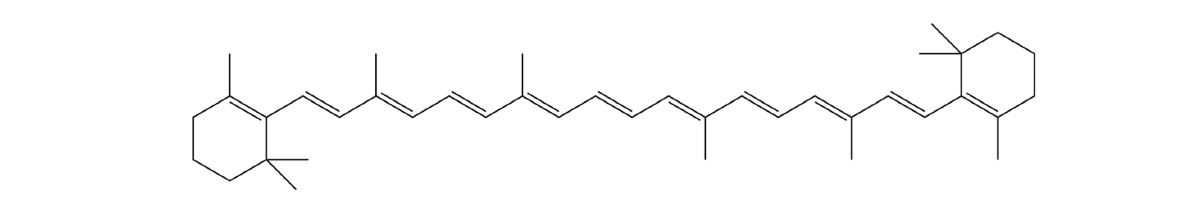
FIGURE 14 Chemical structure of β -carotene.